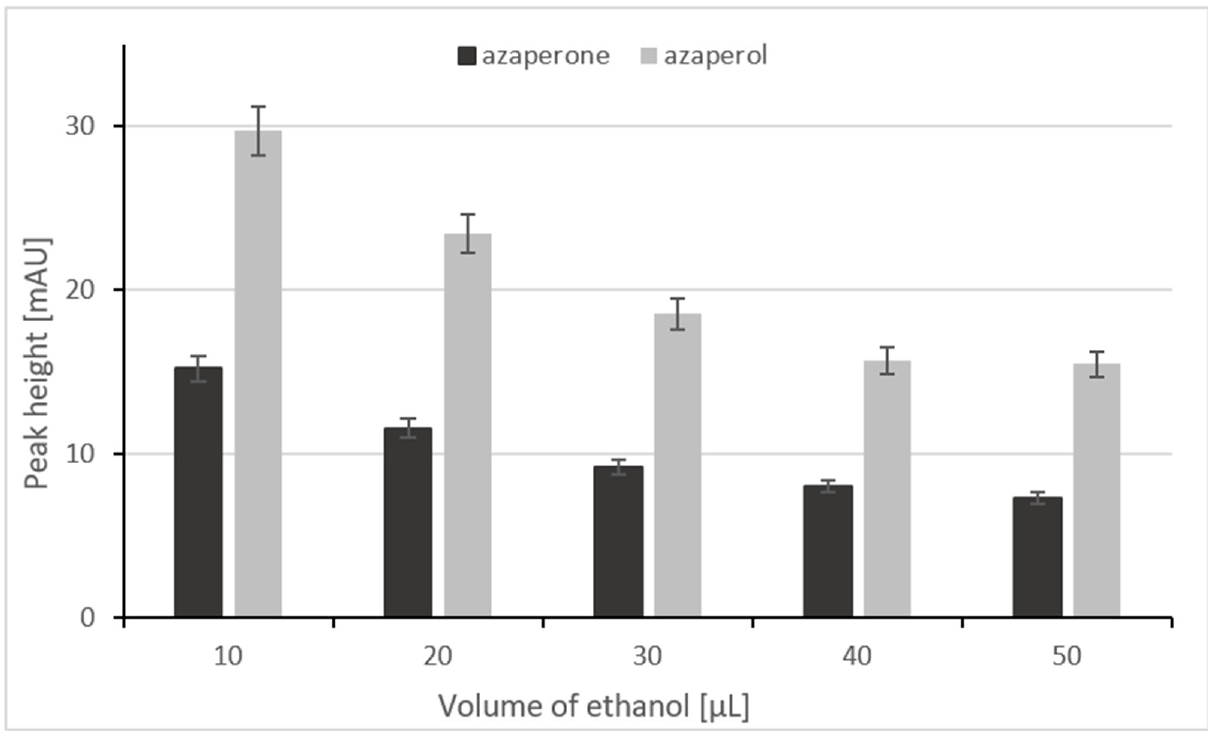
Figure 4. The relationship between the peak height and the volume of ethanol.